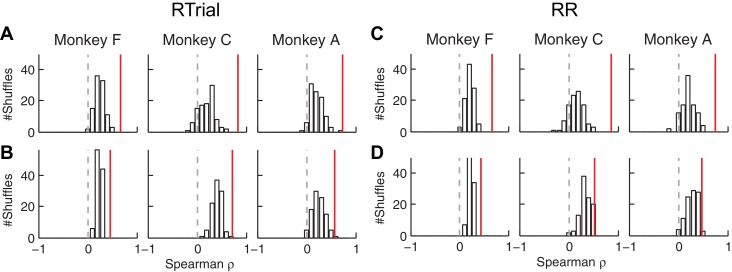
The correlation between fitted and conditionally optimal adjustments was stronger for the real, session-by-session data (red lines) than for unmatched (shuffled) sessions (bars).(A, C) Momentary-evidence (Δme) adjustments. (B, D) Decision-rule (Δz) adjustments. (A, B) optimal values obtained with the RTrial function. (C, D) optimal values obtained with the RR function. Red lines indicate the partial Spearman correlation coefficients between the fitted and optimal Δme or Δz (obtained in the same way as the data in Figure 6E) for matched sessions. Bars represent the histograms of partial correlation for unmatched sessions, which were obtained by 100 random shuffles of the sessions (i.e., comparing the optimal and best-fitting values from different sessions). Note that the histograms for the unmatched sessions are centered at positive values, reflecting the non-session-specific tendency of reward surfaces to skew towards overly biased me and z values. The correlation values for matched sessions (red lines) are at even more positive values (Wilcoxson rank-sum test, p<0.001 for all three monkeys and both Δme and Δz), suggesting additional session-specific tuning of the me and z parameters.